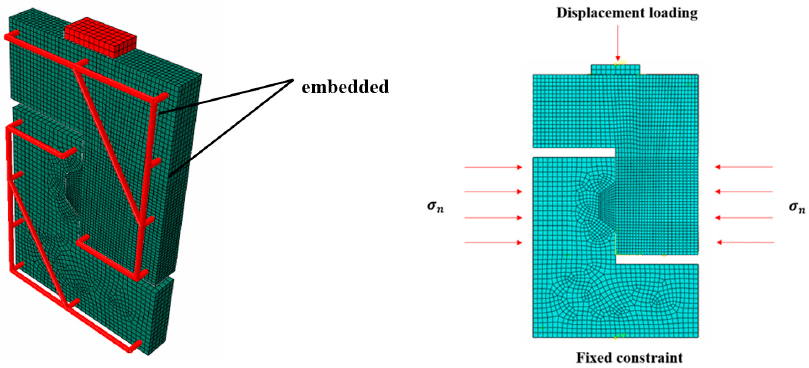
Figure 5. Finite element model of the single-keyed dry joint.